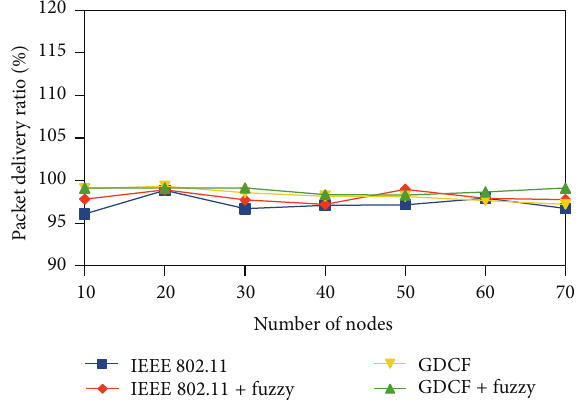
Figure 15: Packet delivery ratio for variable nodes and traffic.